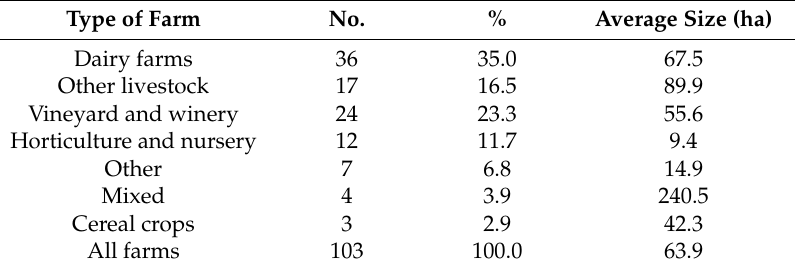
Table 1. The sample farms in the first survey.